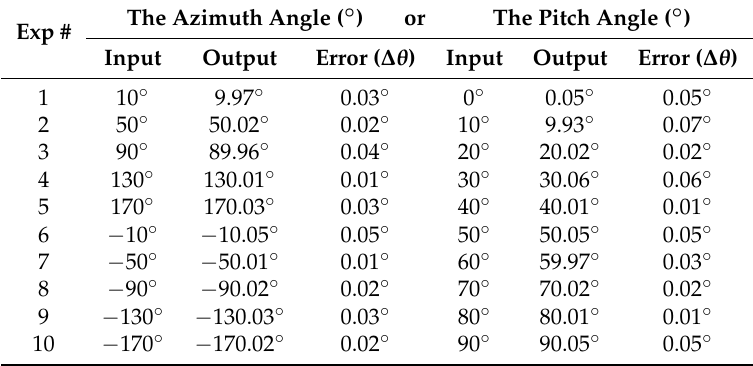
Table 2. The experimental results of direction estimates.